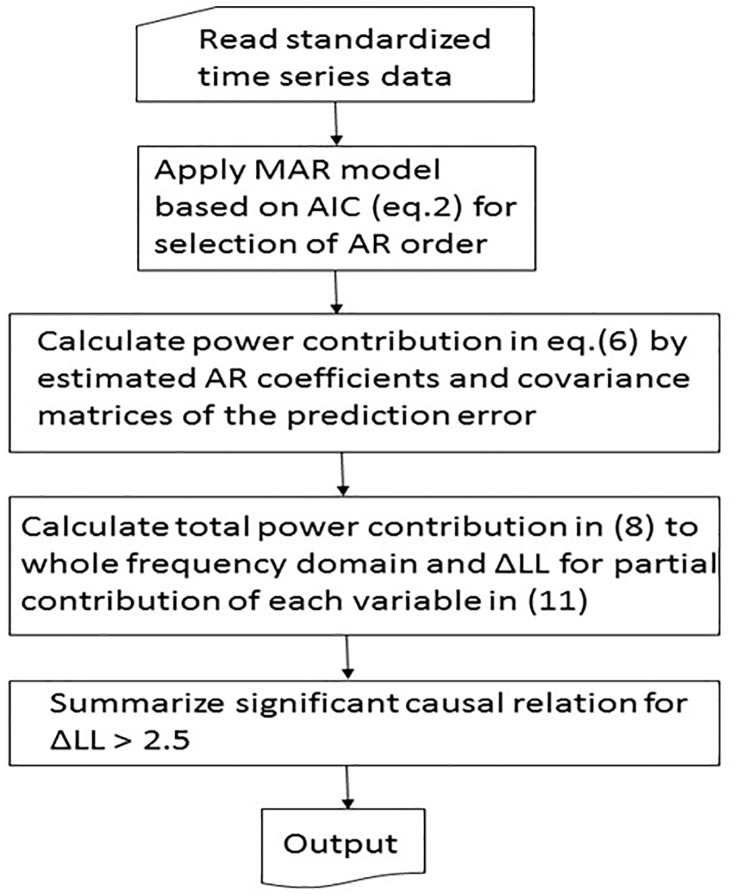
Block diagram of the algorithm summarizing the calculating procedure of ΔLL.